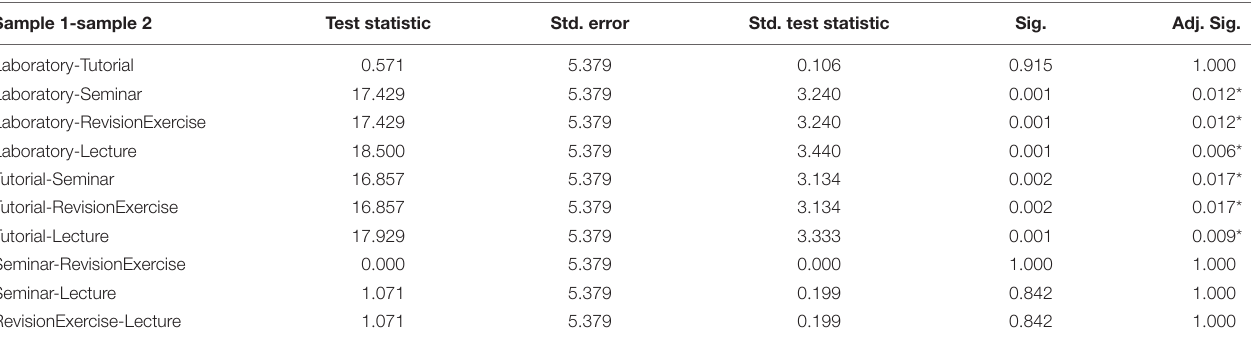
TABLE 6B | Post hoc pairwise comparisons for Hypothesis 1.